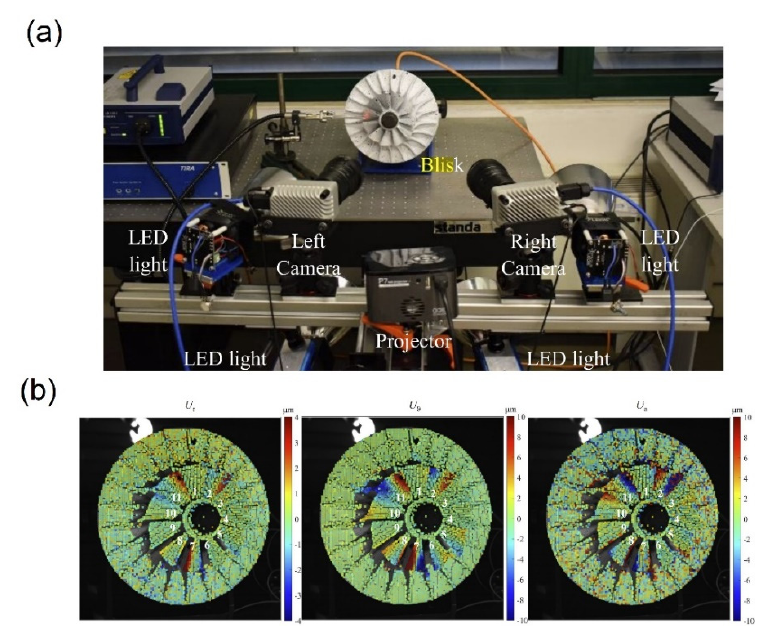
Figure 7. ( a ) Optical setup of the stereo-digital image correlation measurement and ( b ) Displacement maps for the 6239 Hz excitation frequency (reprinted with permission from [140].